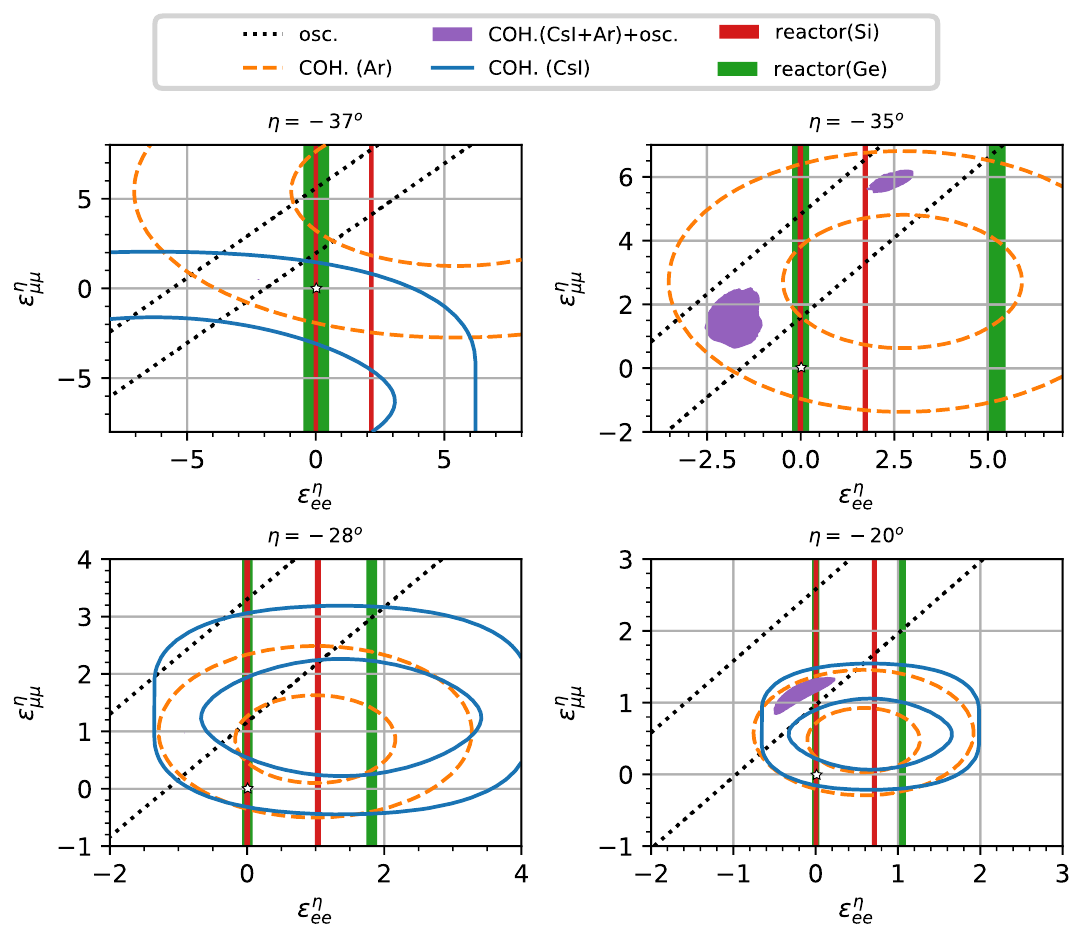
Figure 7 . Same as figure 2 with sensitivity of the reactor experiments using Ge and Si overlaid assuming a 5% measurement of the weak charge Q SM